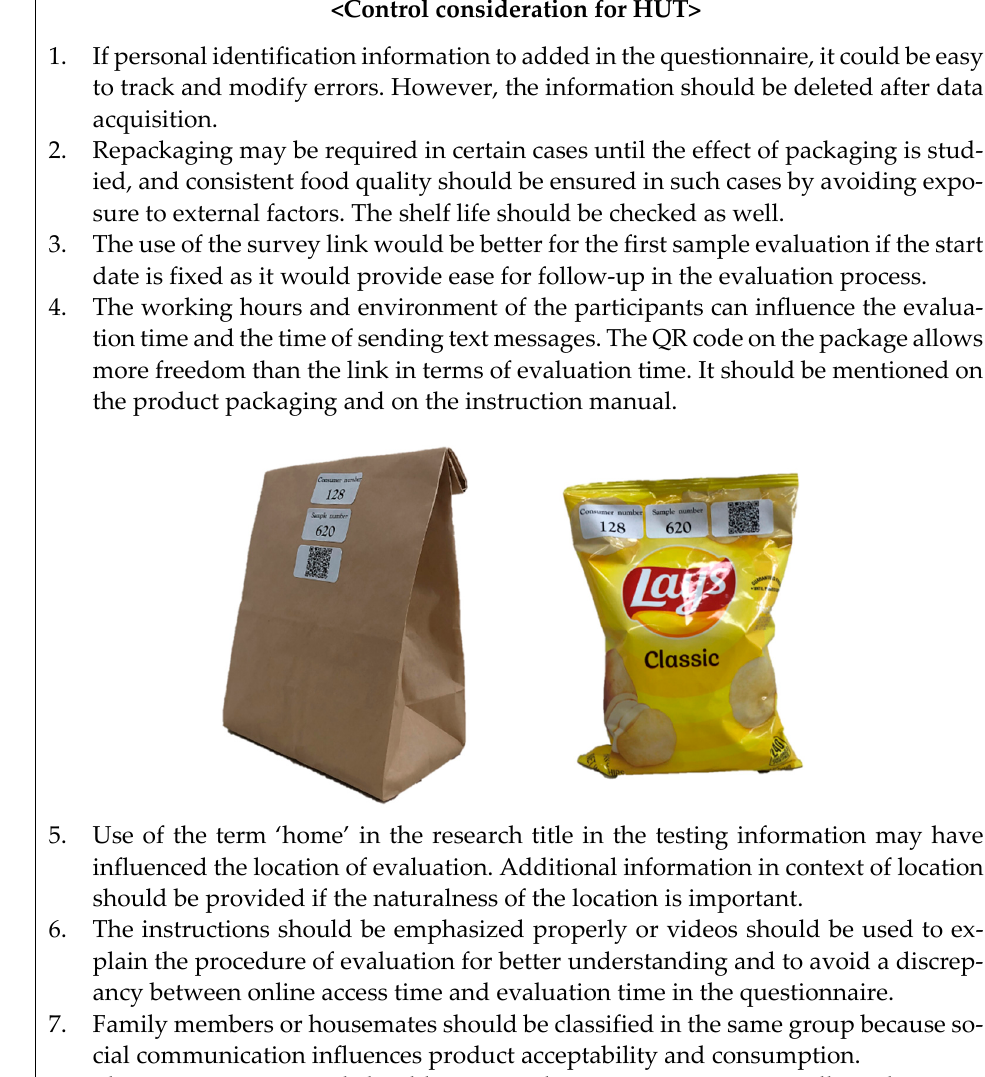
Figure 5 . A summary of instructions in